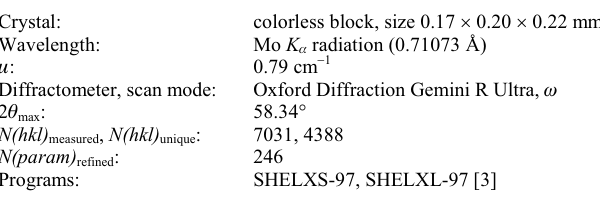
Table 1. Data collection and handling.